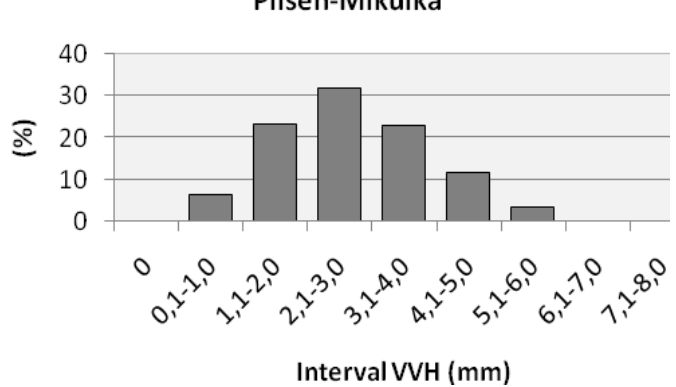
Fig. 8. Pilsen-Mikulka, frequency of daily evaporation sums from water surface in the specified intervals (2005-2014) Table 4. Average values of basic meteorological parameters at the stations in Prague-Libuš and Pilsen-Mikulka